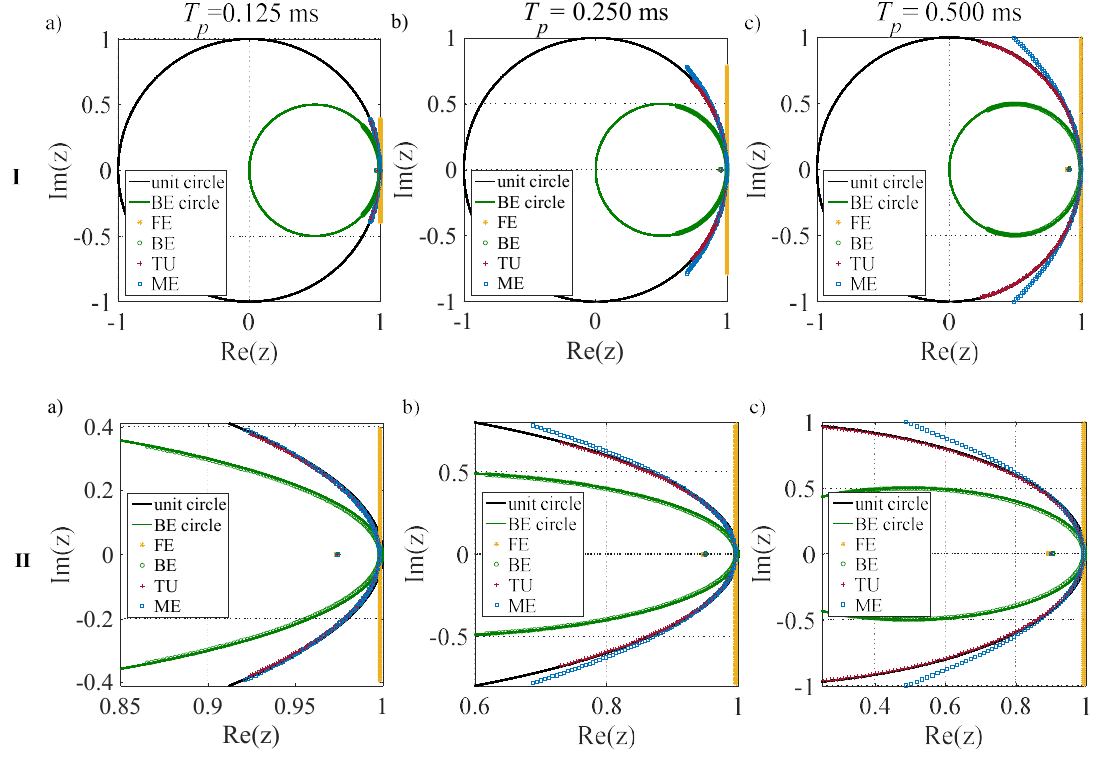
Figure 5. Poles location of the discrete MRAS CC estimator modelled in stationary reference frames ( α– β ) discretized using numerical methods FE, BE, TU and ME for different sampling steps in the speed range ω m = (0 − 10) ω mN . Row I—all poles location, row II—zoom on the stability border. Column ( a ): T p = 0.125 ms, column ( b ): T p = 0.250 ms and column ( c ): T p = 0.500